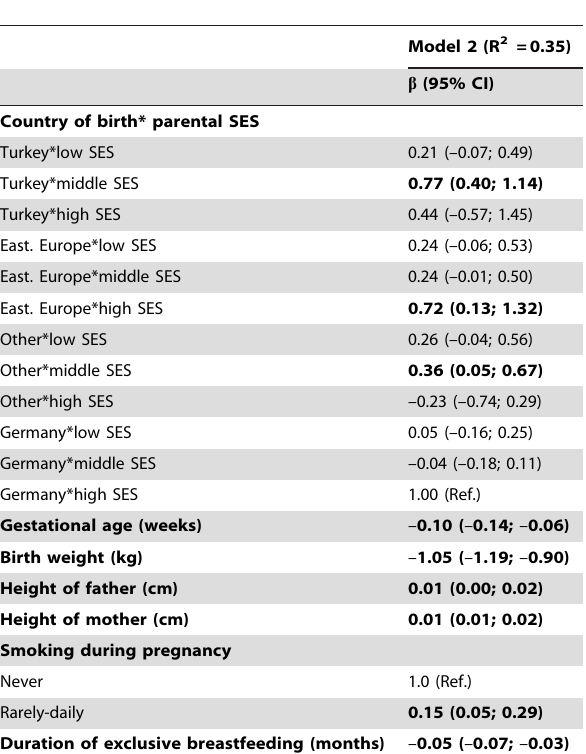
Table 6. Odds ratios (and 95% CI) for influence of migrant background and parental socioeconomic status on rapid weight gain between birth and six months of life, adjusted for covariates (n